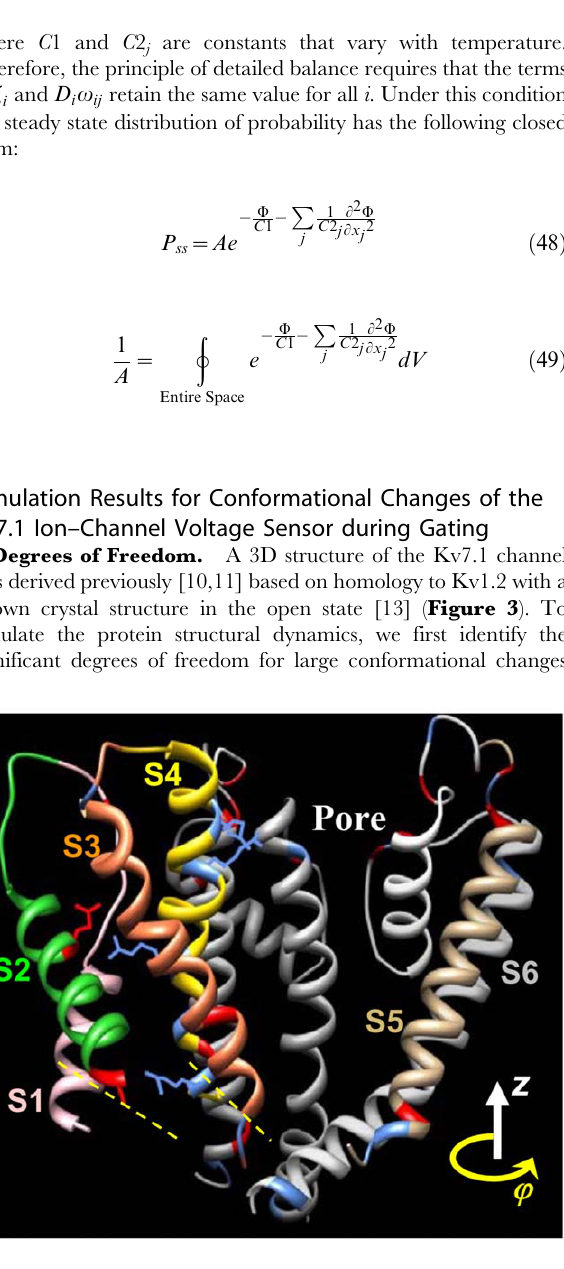
Figure 3. 3D structure of Kv7.1 (one subunit) and its transmembrane helices in the open conformation. The structure was computed based on homology with Kv1.2 using its known crystal structure [13]. Motion of the S4–S3 complex is assumed to be the major conformational change during channel opening and closing (gating). The loop connecting S2 to S3 and the linker connecting S4 to S5 are not ð 46 shown (dashed lines). Dark gray helices are S5 and S6 of the neighboring subunit. Red segments are negatively charged residues and blue segments are positively charged residues.